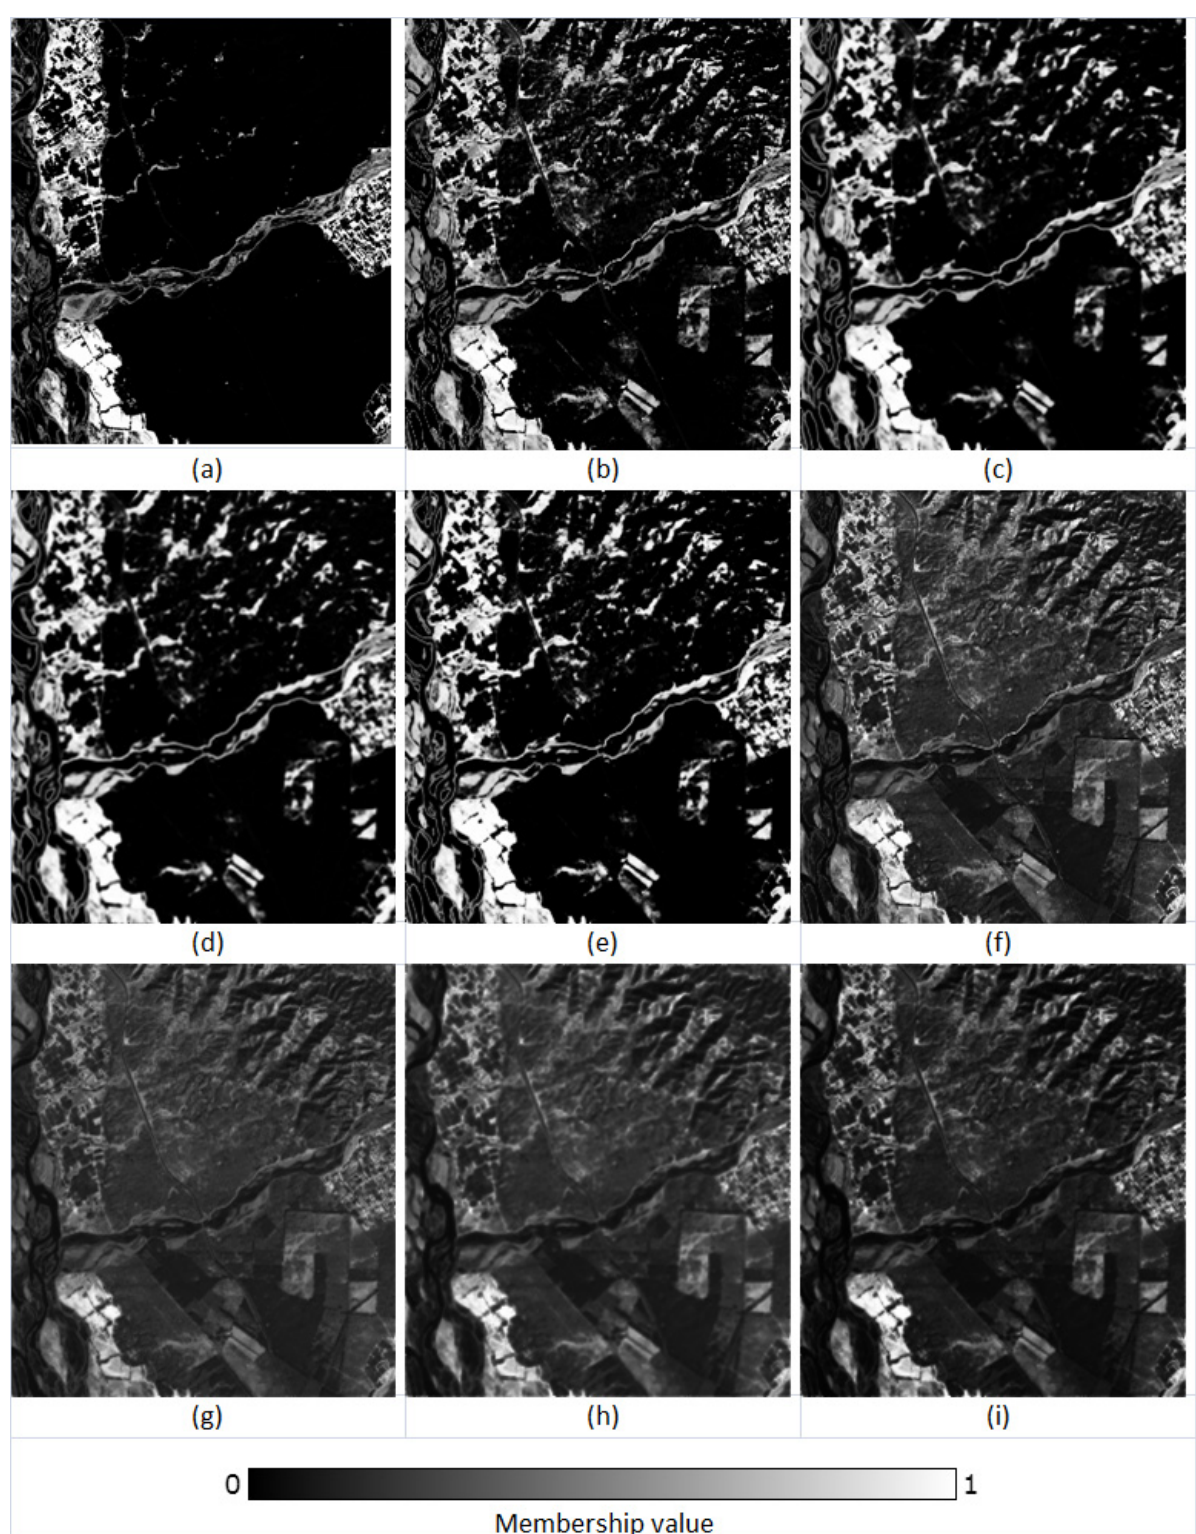
Figure 6. The membership fraction (0–1) for the class ‘Grassland’ in ( a ) reference, ( b ) FCM output, ( c ) FCM-S output, ( d ) FLICM output, ( e ) ADFLICM output, ( f ) PCM output, ( g ) PCM-S output, ( h ) PLICM output, and ( i ) ADPLICM output.